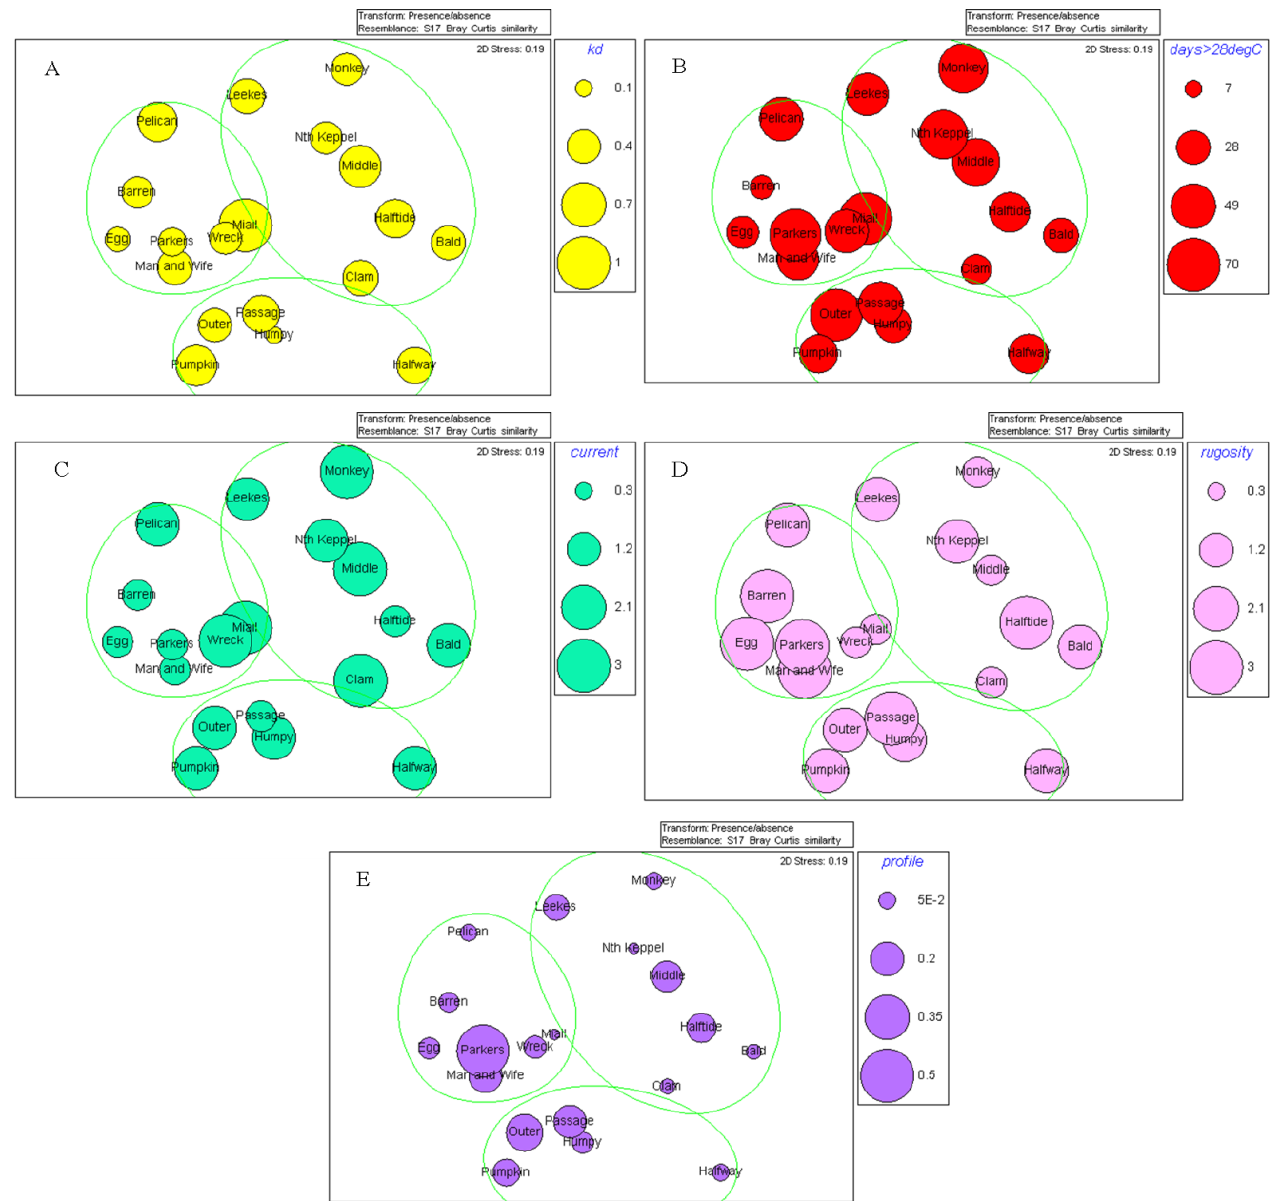
Figure 8. Bubble plots of the five environmental variables. (A) light extinction coefficient (K = 0–1); (B) temperature (days >28 °C); (C) current (1 = strong; 2 = medium; d 3 = weak); (D) rugosity (1 = high rugosity; 2 = average rugosity; and 3 = low); and (E) reef profile (0–0.5) superimposed on the 2-D MDS plot of sites of the Bray Curtis similarities based on the presence/absence of 167 scleractinian coral species at 19 sites in the Keppels. Bubble scales for each variable are shown to the right of the